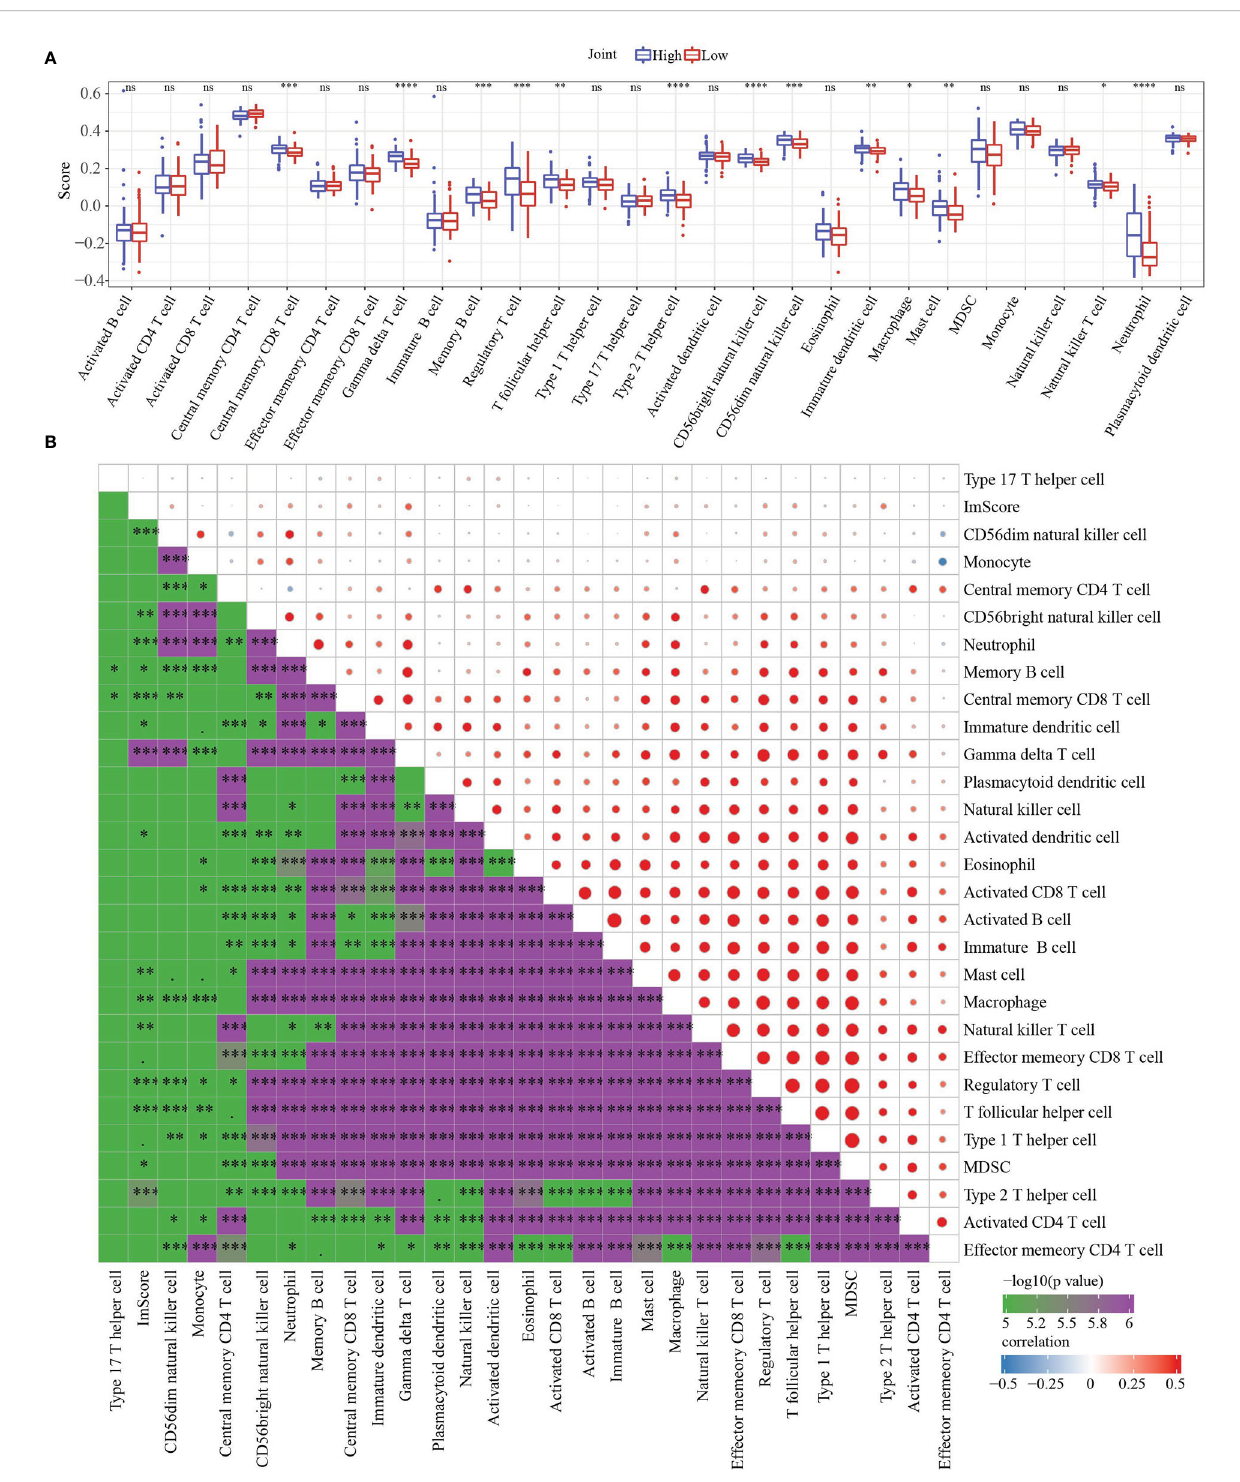
FIGURE 9 Immune characteristics and Functional enrichment analysis. (A) 28 immune cells scores differences between high group and low group determined by ssGSEA. (B) the correlation analysis between RiskScore and 28 immune cells scores. * p<0.05, ** p<0.01, *** p<0.001, **** p<0.0001, ns, no